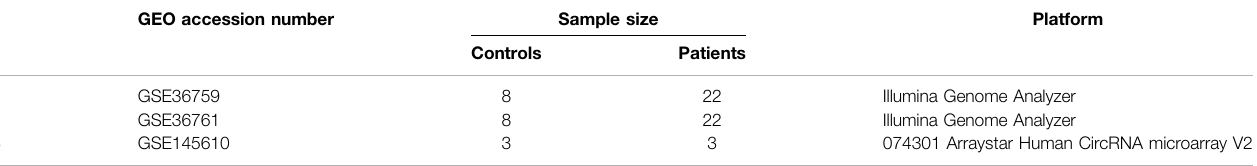
TABLE 1 | Microarray and RNA sequencing datasets from GEO were incorporated into this study. GEO accession